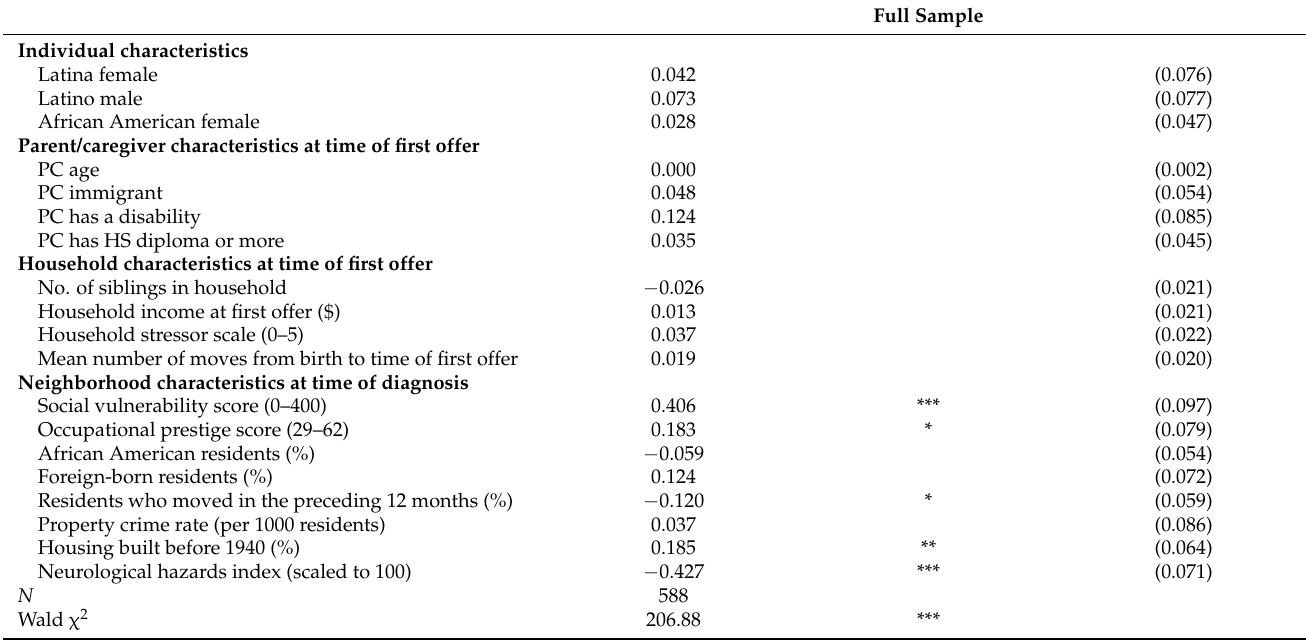
Table 3. Average Marginal Effects from IV Probit Models Predicting the Probability of Ever Being Diagnosed with a Neurodevelopmental